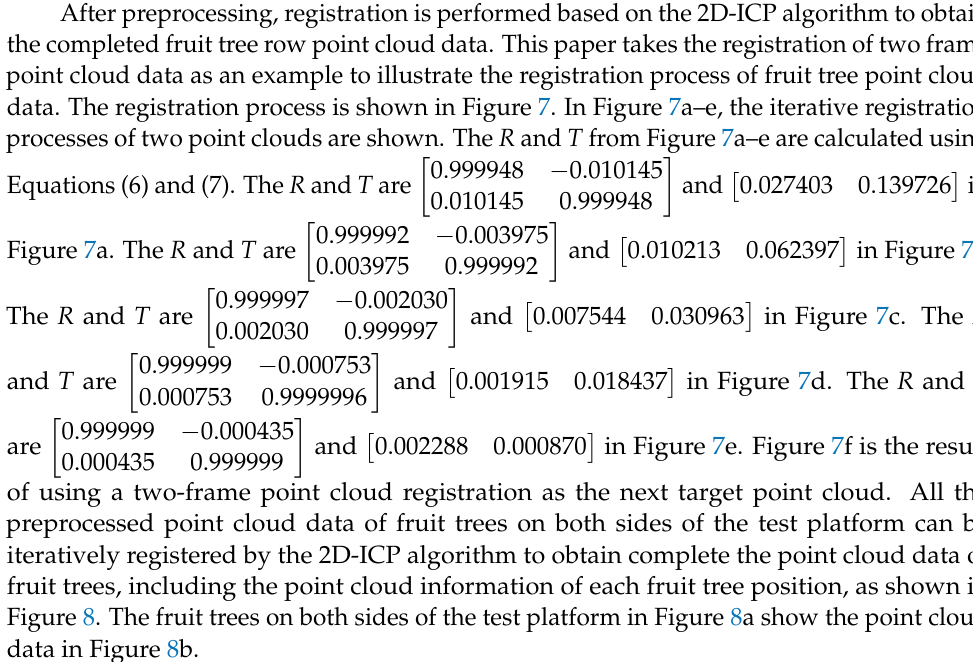
Figure 7a. The R and T